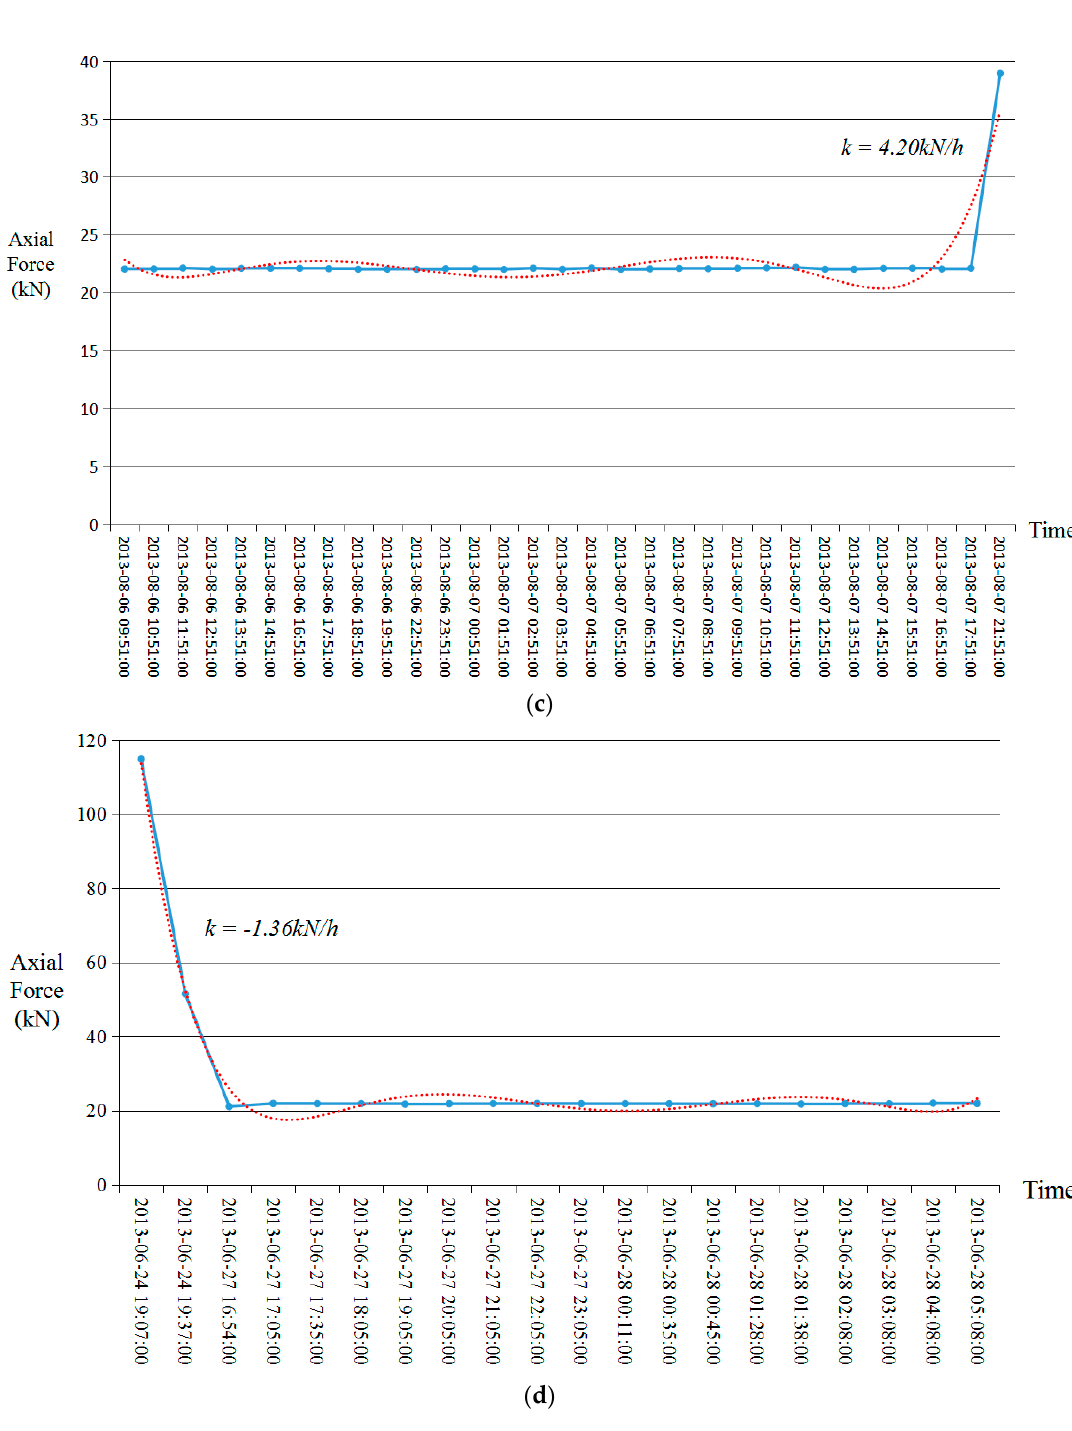
Figure 11. The time-dependent axial force measured by FRP (the x -axis is time in year-month-day: hour: minute: second). ( a ) Original monitoring data; ( b ) the rising section of red box I in ( a ); ( c ) the rising section of red box II in ( a ); ( d ) the descending section of red box I in ( a ).